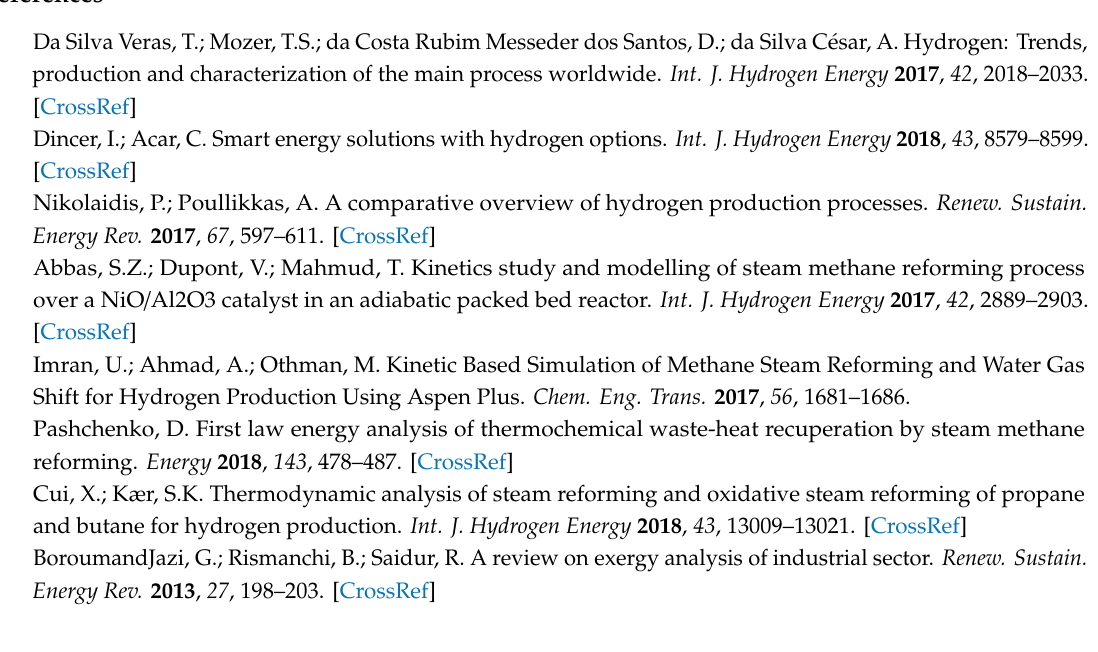
Table S1: Natural gas composition, Table S2: SYN-GAS HDS composition, Table S3. Utility costs for air / fuel molar ratio of